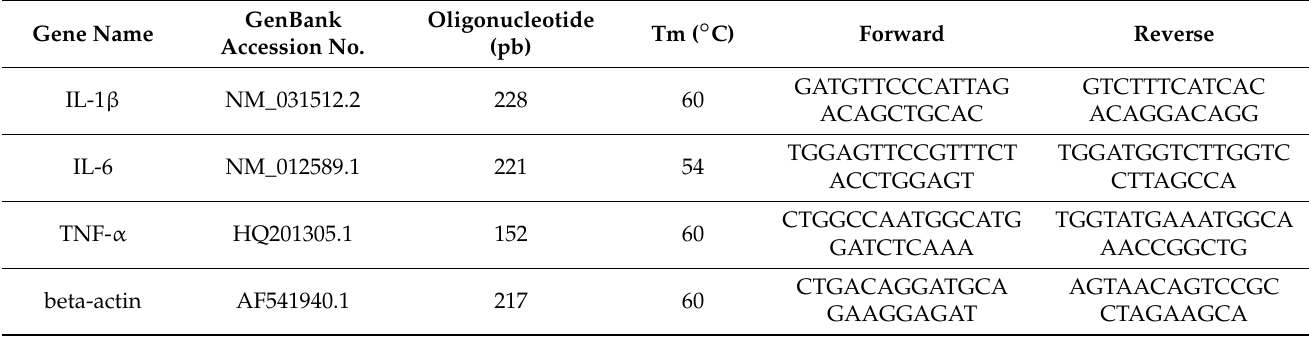
Table 1. Oligonucleotides for gene expression assessment. From left to right: gene name, gene bank oligonucleotide (pb), TM ( ◦ C), primer sequence, forward and